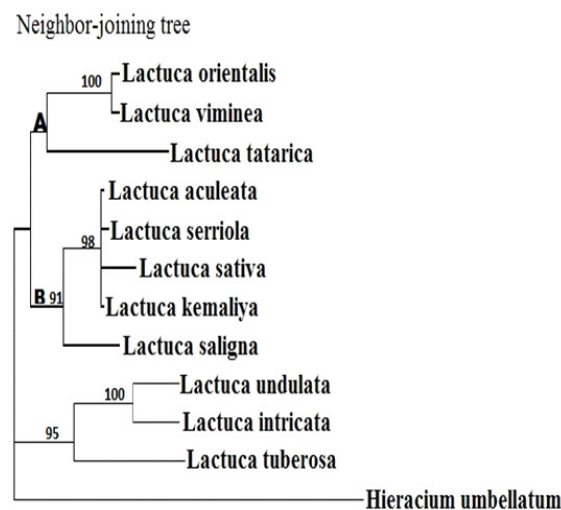
Fig. 1. The Neighbour Joining tree generated using ITS DNA sequences of genus Lactuca specimens and the related sequences retrieved from NCBI GenBank